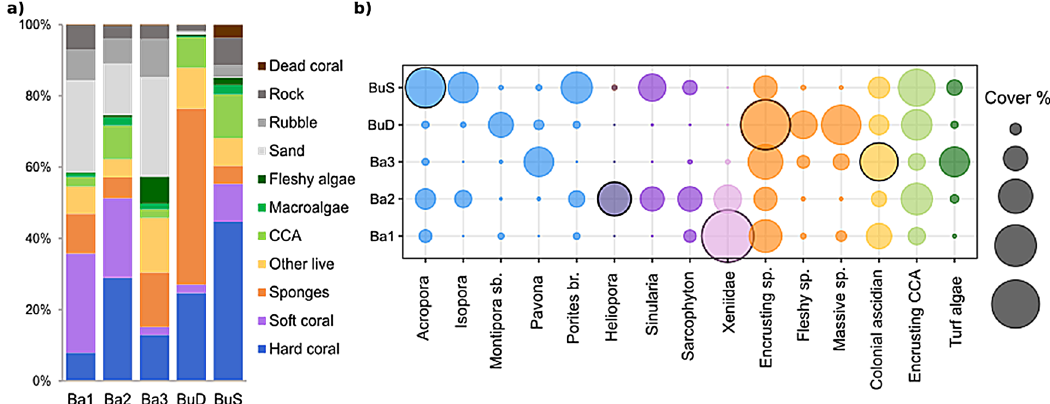
Figure 3. Benthic composition (based on major categories) of the different community regimes identified ( a ) and cover (%) of the most abundant (≥ 5% at least in one regime) benthic taxonomic categories identified ( b ). Highlighted circles represent the dominant benthic organism in each of the